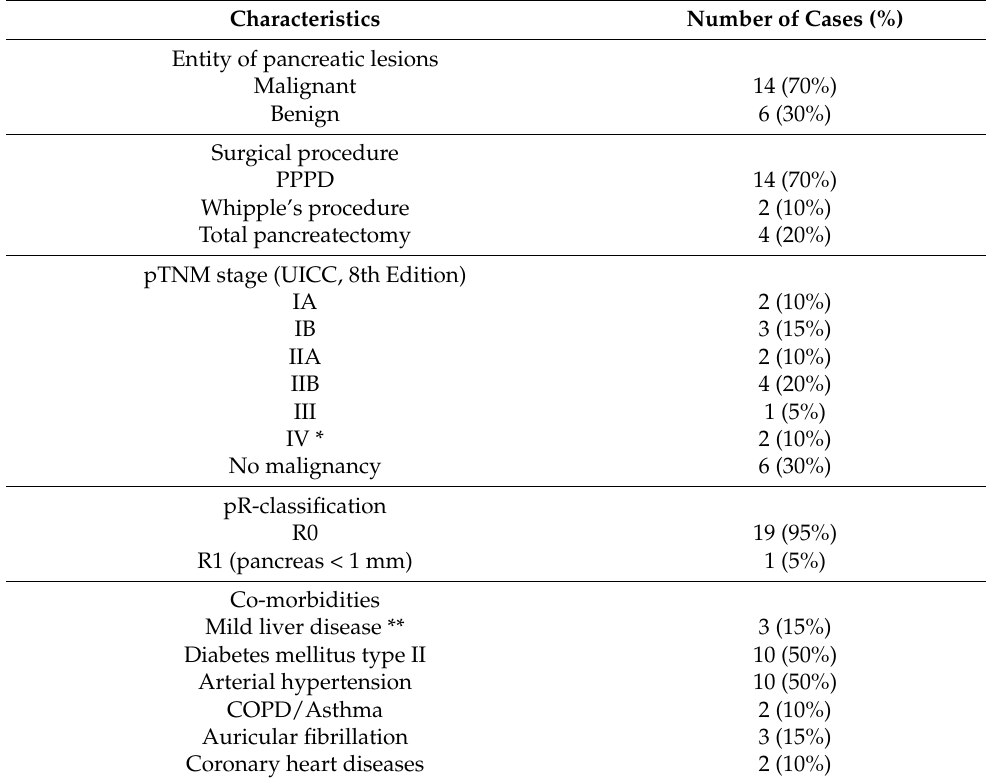
Table 3. Patients’ histological characteristics.